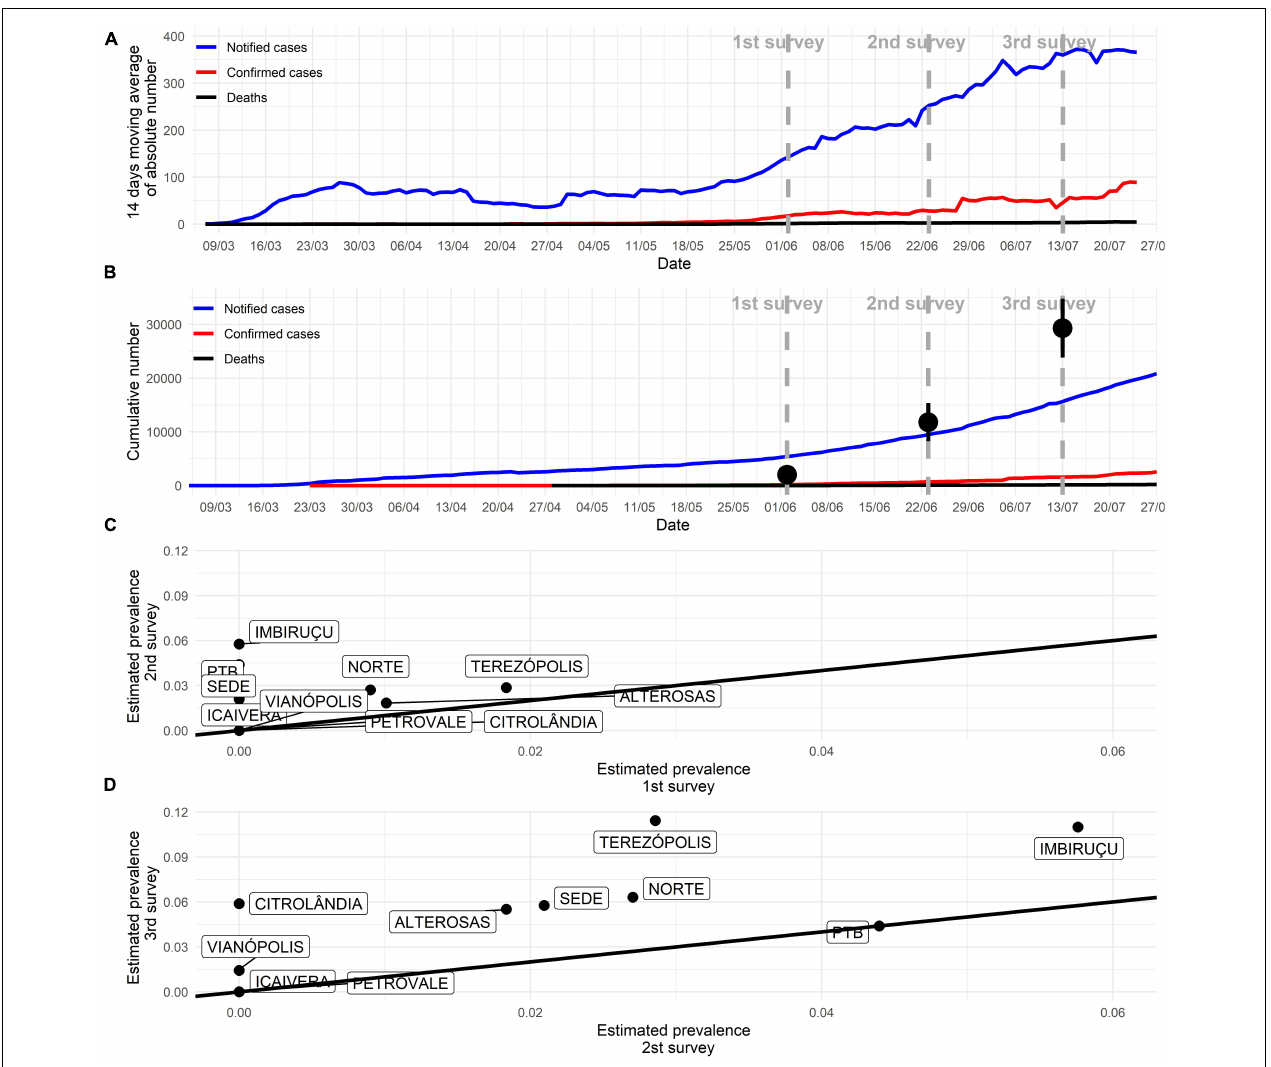
FIGURE 2 | COVID-19 pandemic progression in Betim. (A) The absolute number of new cases according to official city statistics. (B) The cumulative number of cases according to official city statistics. Black dots indicate estimated overall prevalence (immunological and molecular tests) in the current study with its 95% confidence interval. Distance from black dots and red curve represent underreporting. (C,D) Overall prevalence (immunological and molecular tests) comparison in each of the 10 administrative regions of the city across successive surveys. An increase was observed in most areas from the first to the second survey and, more substantially, from the second to the third